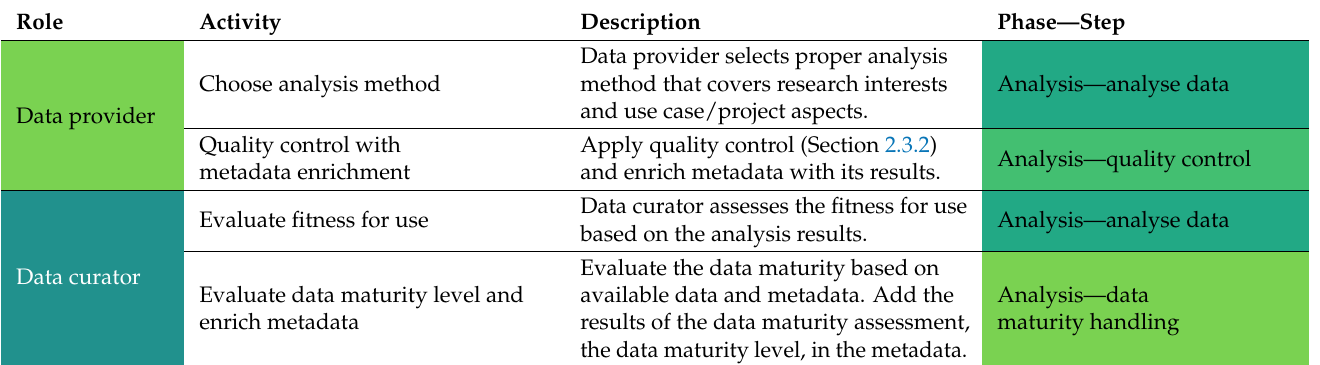
Table 12. Roles and their activities with descriptions at analysis phase.